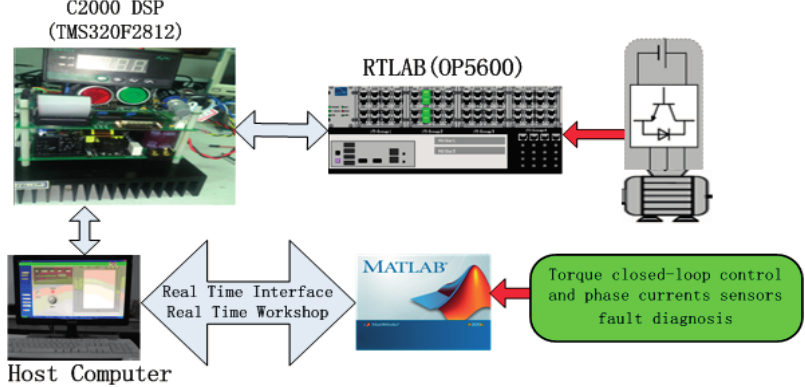
Figure 23. The Structure of RT-LAB hardware-in-the-loop system.